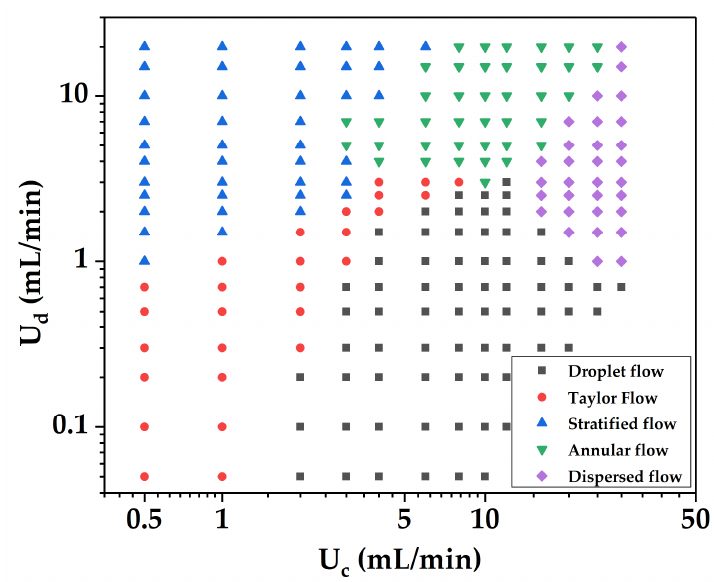
Figure 9. Flow pattern map of two-phase flow in the microreactor.